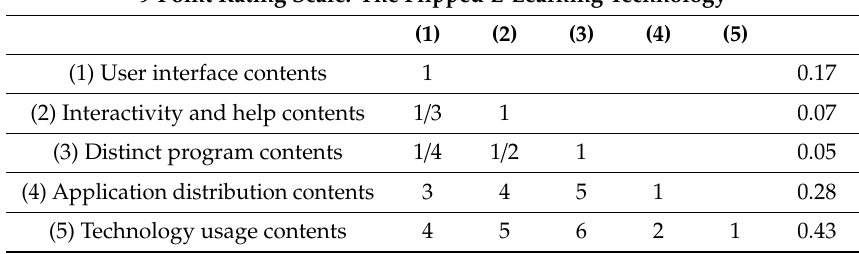
pair-wise comparison matrix. Table 5. The flipped e-learning technology criteria computation of the five sub-criteria, along with a